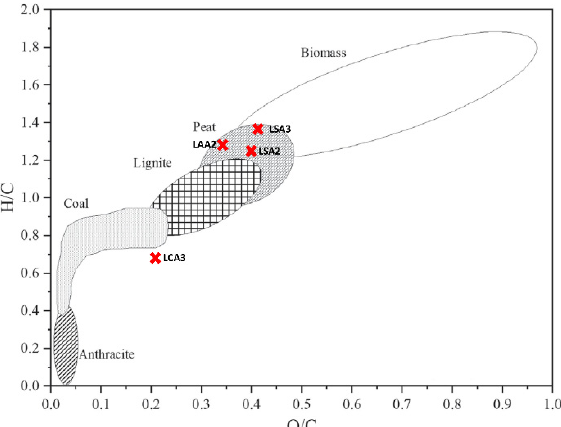
Figure 10. Position of the resultant Briquette on the Van Kravelen diagram (adapted and modified from [31]).